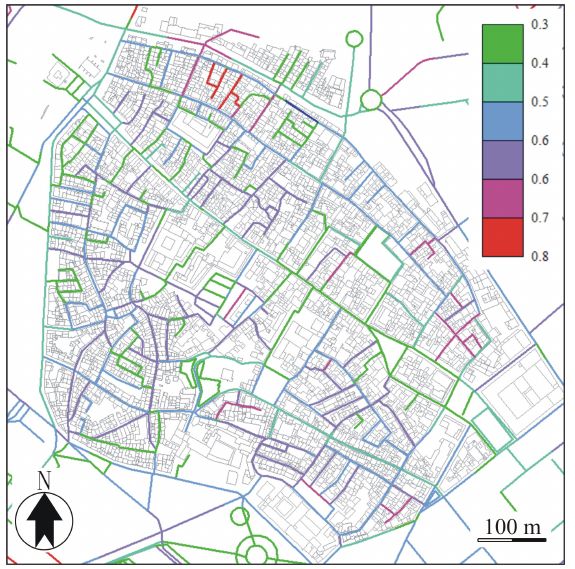
Figure 2. Map representing the unit costs of the street arcs as resulting from data collected through an direct audit.